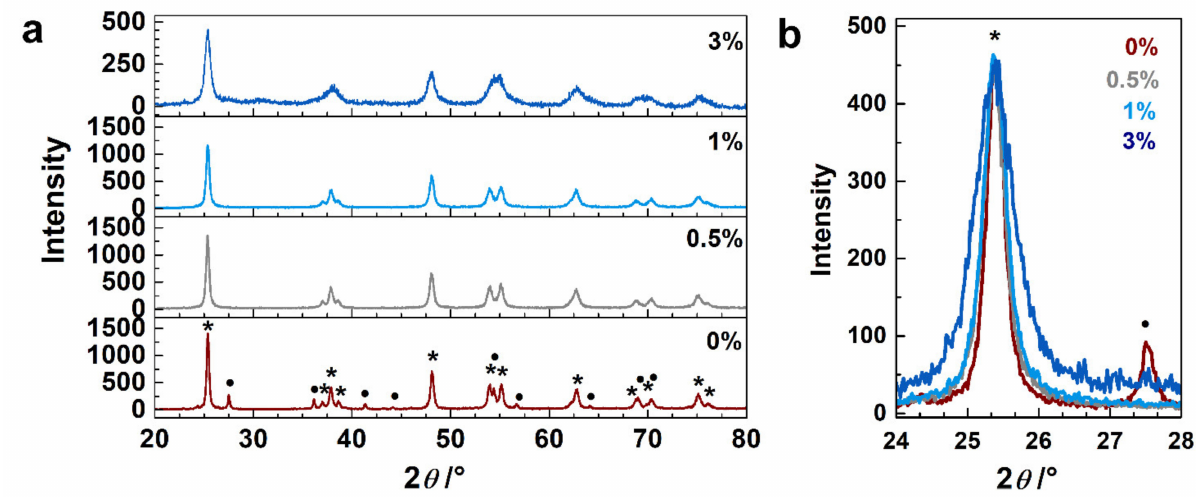
Figure 1. ( a ) Powder XRD patterns of undoped TiO 2 sample and samples doped with 0.5, 1 and 3 wt.% of Nd 3+ . ( b ) Enlarged (101) peak region; for all samples the intensity of the (101) peak was normalized to the peak of the 3-Nd–TiO 2 . Peaks marked with * stand for anatase while • for